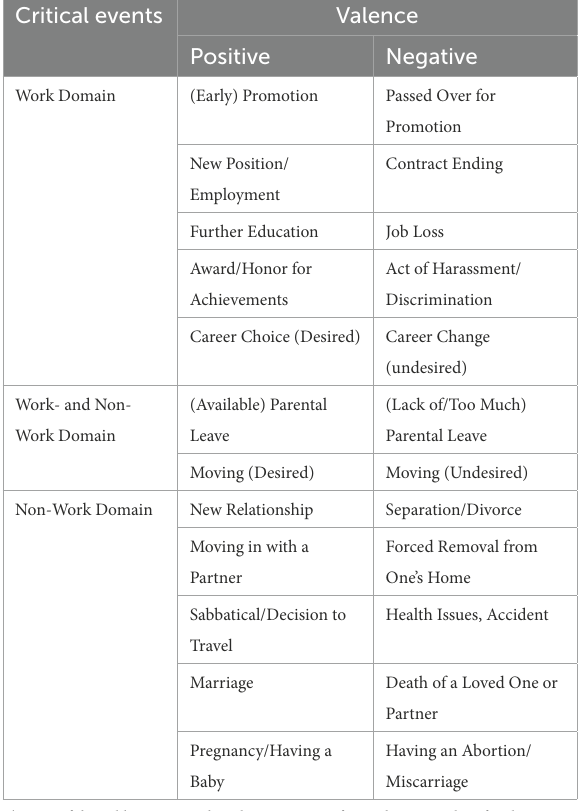
TABLE 1 Overview of examples of key (Early Career) critical